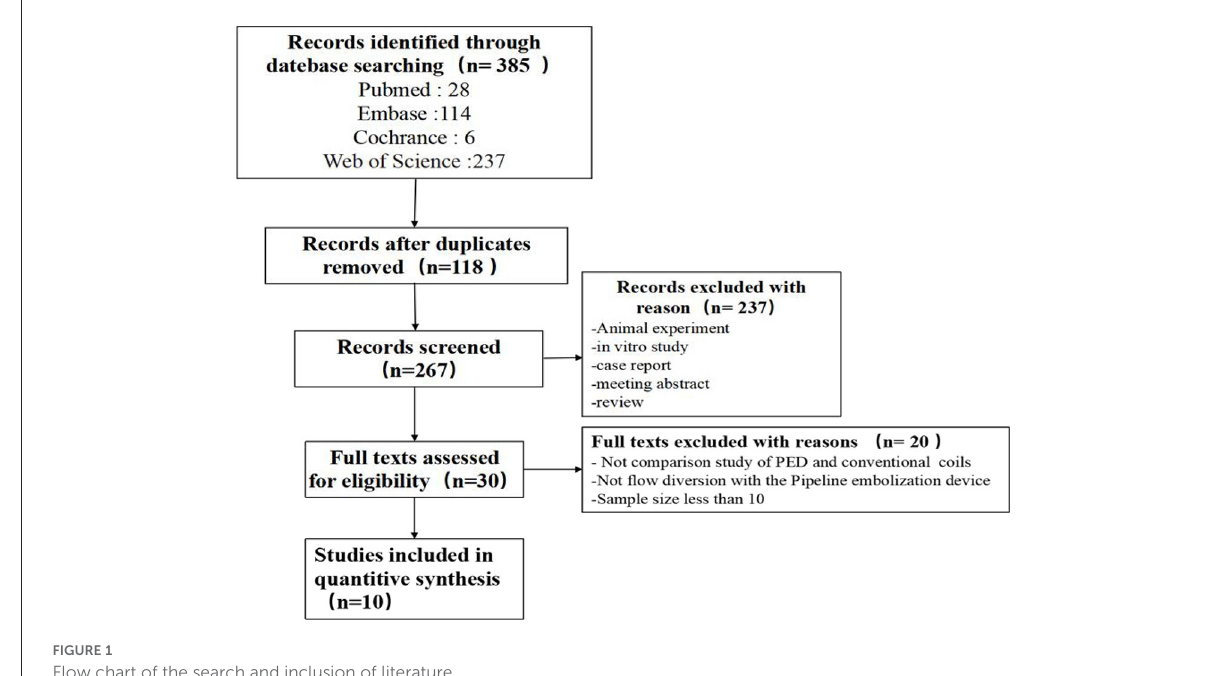
FIGURE1 Flow chart of the search and inclusion of literature.